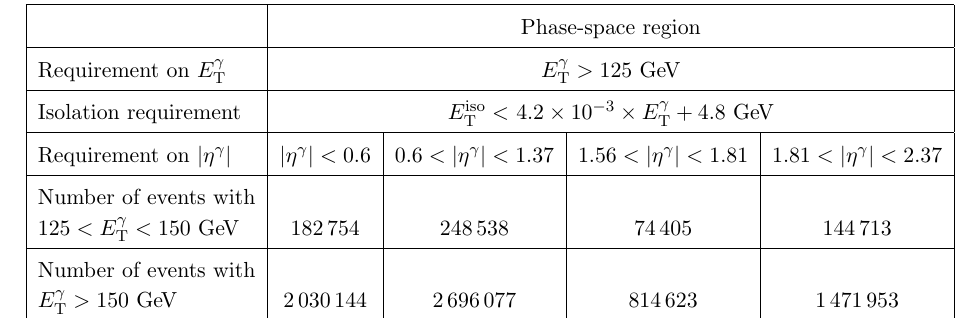
Table 1 . De(cid:12)nition of the phase-space region for the measurement and predictions. The (next- to) last row indicates the number of data events selected in each j (cid:17) (cid:13) j region for E (cid:13)